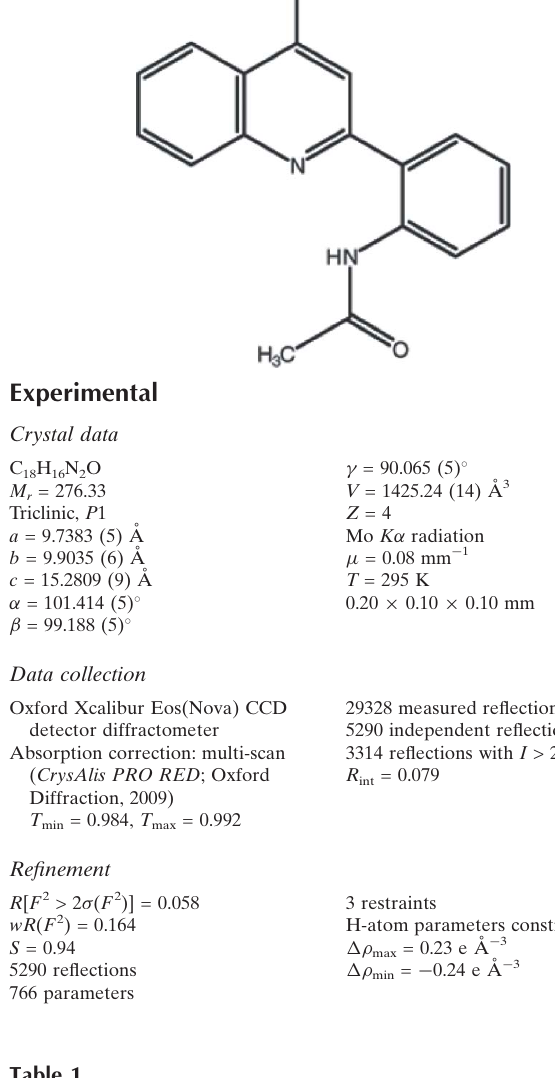
Hydrogen-bond geometry (A ˚ , (cid:2)